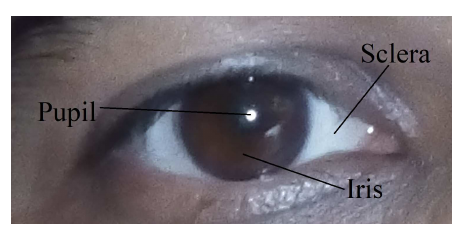
Figure 2. Eyeball’s